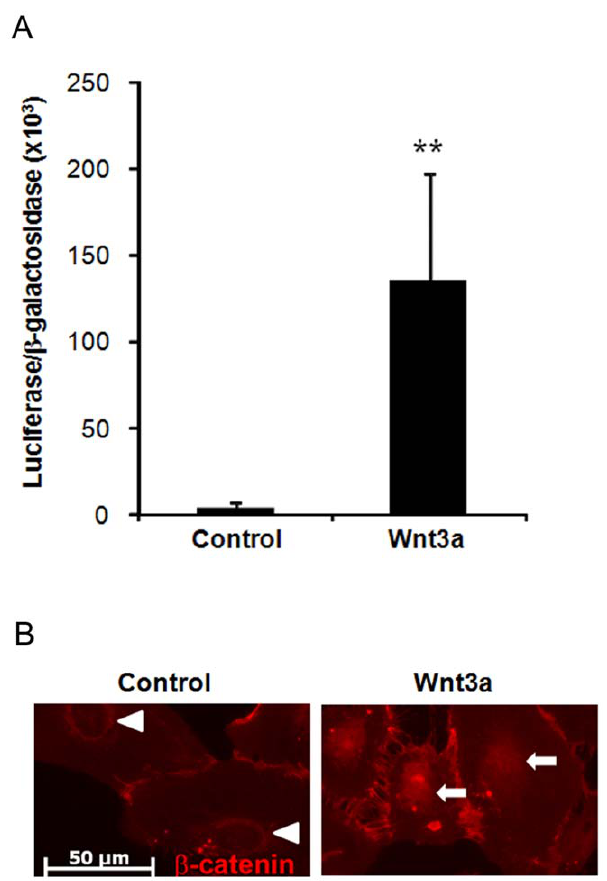
Figure 1. Activation of Wnt signaling in the RPE cell line ARPE- 19. (A) Cultured cells were co-transfected with the TOP-FLASH Wnt reporter plasmid and a plasmid containing b -galactosidase, and then incubated with Wnt3a or control conditioned media. Luciferase activity was normalized to b -galactosidase activity. Wnt3a induced a 32-fold increase in luciferase activity compared with control (n=4, **p=0.01). (B) Immunodetection of endogenous b -catenin was used to confirm Wnt signaling induction. Cells incubated in control conditioned media have predominantly cytoplasmic and membrane-associated b -catenin (red, arrowheads), indicating low basal levels of Wnt signaling. Stimulation with Wnt3a induced translocation of b -catenin into the nucleus (right, arrows), indicating activation of the Wnt pathway. Scale bar 50 m M.